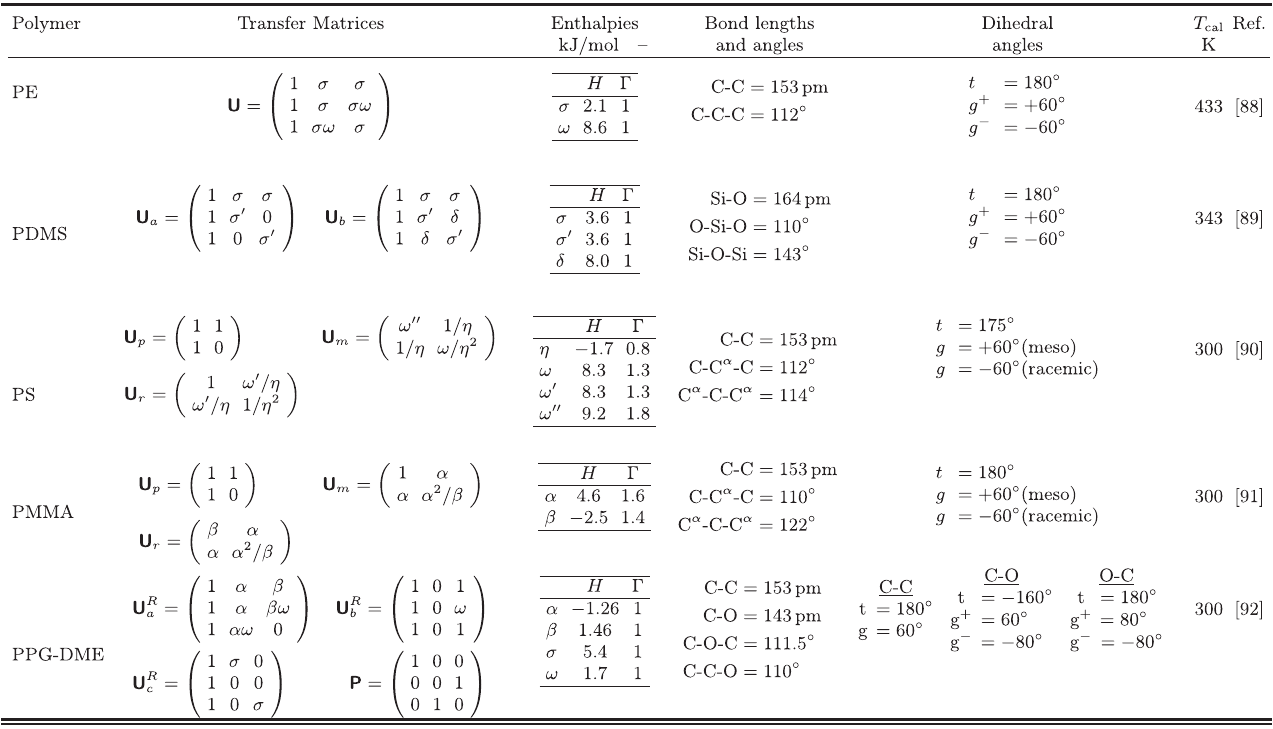
TABLE II. RIS data used for calculations. The transfer matrices U describe the relative weights of successive rotational isomeric states specified by the dihedral angles. The matrix indices label ( t , g ) or ( t , g þ , g − ) dihedral angles. Matrix elements have the form σ ¼ − H σ =k − H ω =k Γ B T ; ω ¼ Γ ω e B T ; … : PE has a single, unique bond, specified by U , and is calculated at five different temperatures: 70, 110, σ e M Þ based on data as follows: PDMS, Ref. [12]; PMMA, experimental data 148, 200, and 237 K. All other polymers are calculated at T g ð from Fig. 2 of main text; PPG-DME, interpolated from experimental data in Fig. 2; PS, experimental data from Fig. 2. PDMS has two and U . PS has two distinct bonds, the first specified by U and the second with a phenyl ring distinct bonds (Fig. 6) specified by U a b p asymmetrically placed on either the right or left side relative to the chain direction. Similarly, PMMA has two distinct bonds and an specifies the meso diad (two successive right or left asymmetric carbons), and U specifies the asymmetric carbon. In each case, U m r racemic diad (right/left or left/right sequence). PPG-DME has three dihedral angles ( a , b , c ) and one asymmetric carbon on the backbone chain per repeat unit. Matrices corresponding to a left (S) asymmetrical carbon are obtained from the right (R) matrices according to U S P ¼ PU R i i